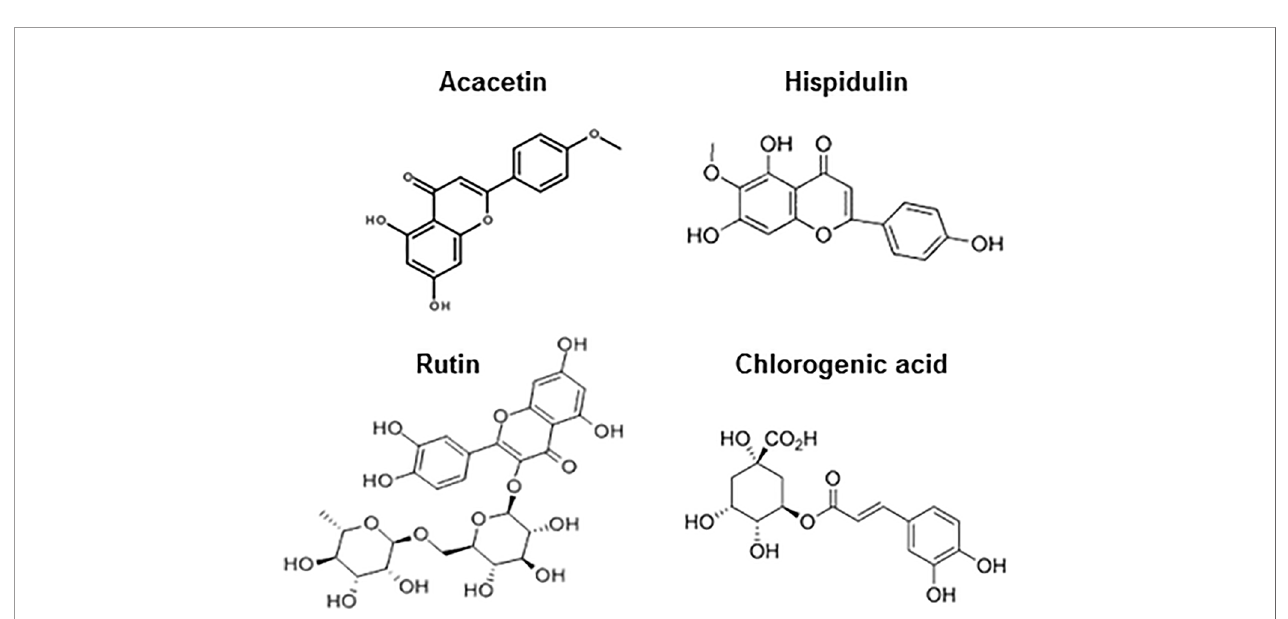
FIGURE 3 | Chemical structures of major bioactive components isolated from Snow lotus. The chemical structures of acacetin, hispidulin, rutin and chlorogenic acid are shown here.